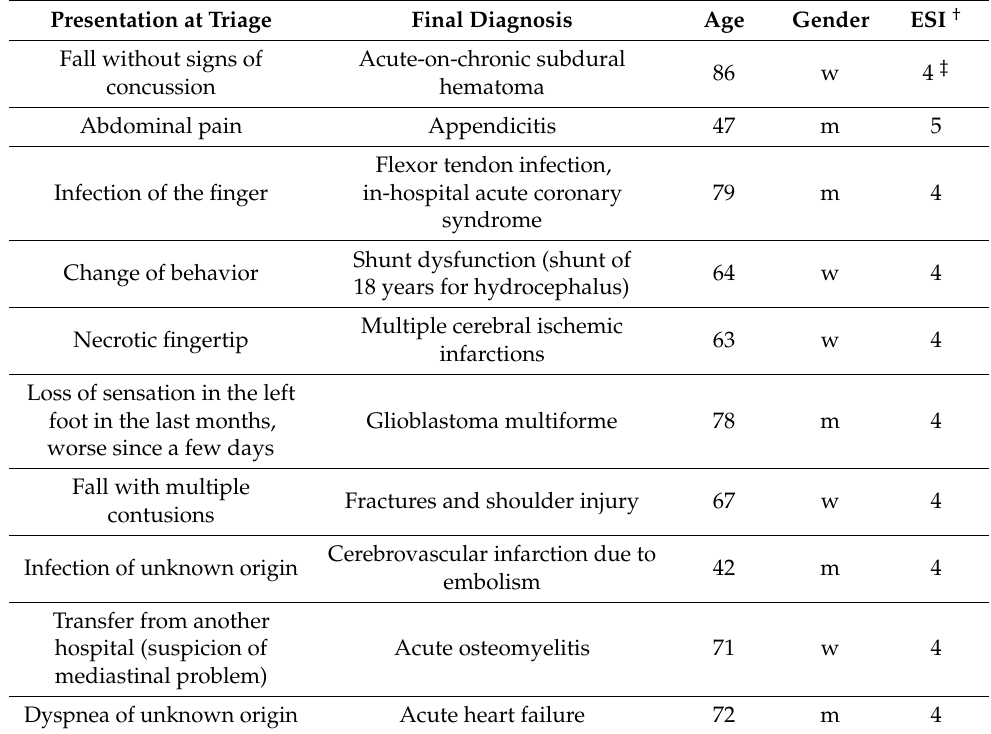
Table A2. Patients with ESI levels 4 or 5 admitted to the ICU *. Presentation at